Question: Which kind of chart has been used to present this data?
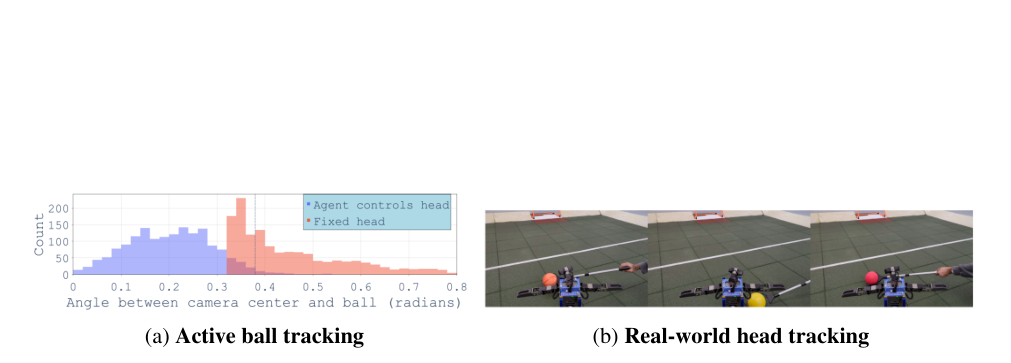
Answer: histogram